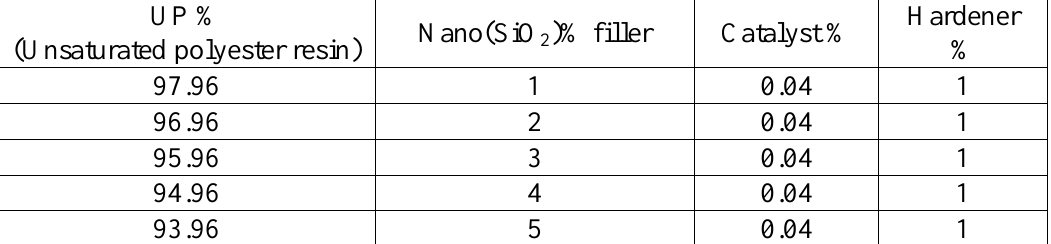
Table 1: Weight ratios of unsaturated polyester resin, silicon oxide nanoparticles (SiO Catalyst % and Hardener %.